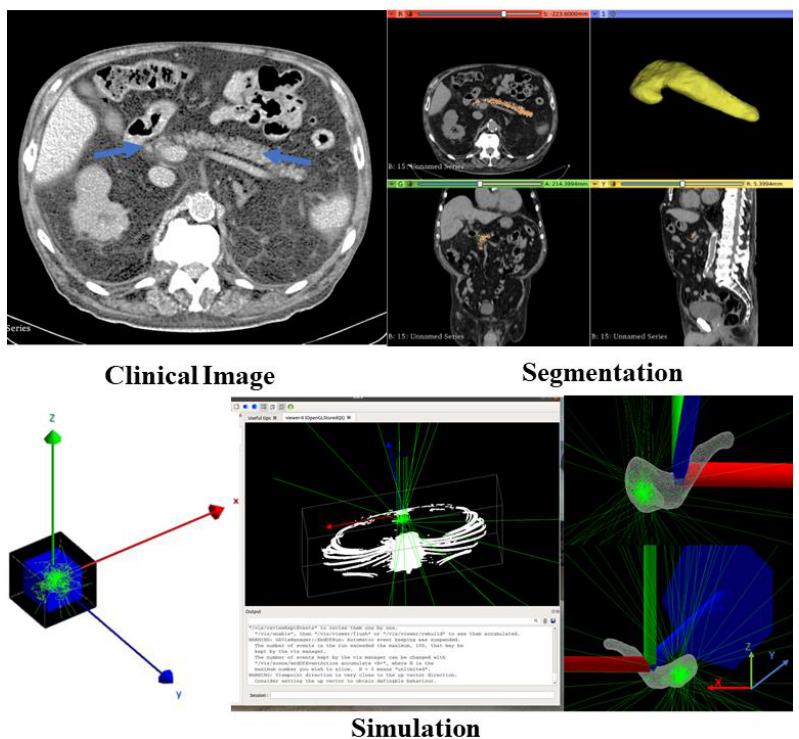
Figure 1. Segmentation of pancreas from the CT scan of abdomen part (clinical image) and simulation the pancreas phantom in GATE software.